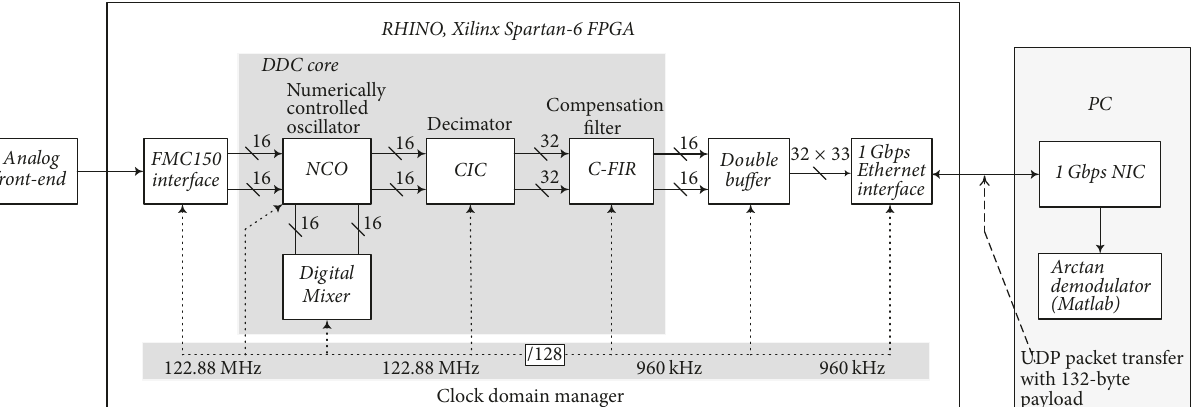
Figure 24: An architecture of the digital FM receiver.